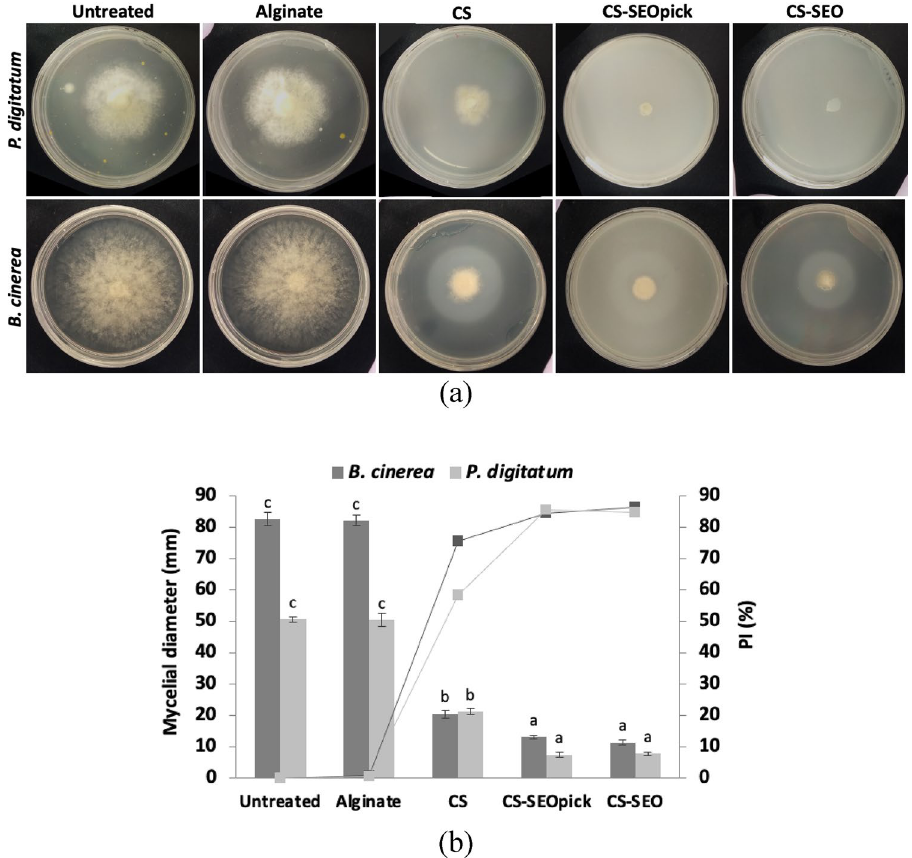
Figure 3. Influence of coating treatment on mycelial growth inhibition of P. digitatum and B. cinerea visually ( a ) and statistically ( b ) in the day 5. Different letters indicate statistically significant differences among different treatments at P < 0.05. CS chitosan, CS-SEOpick chitosan–sandalwood oil Pickering emulsion, CS-SEO chitosan– sandalwood oil regular emulsion treated spores. Alginate represents the common commercial edible